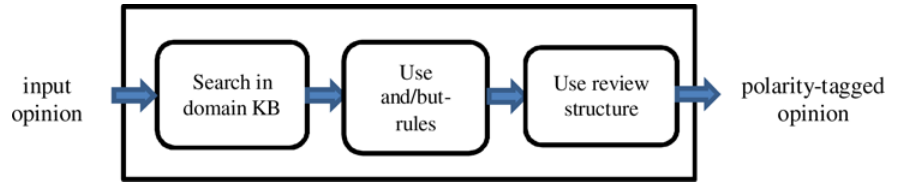
Fig 3. The overall view of the polarity detection